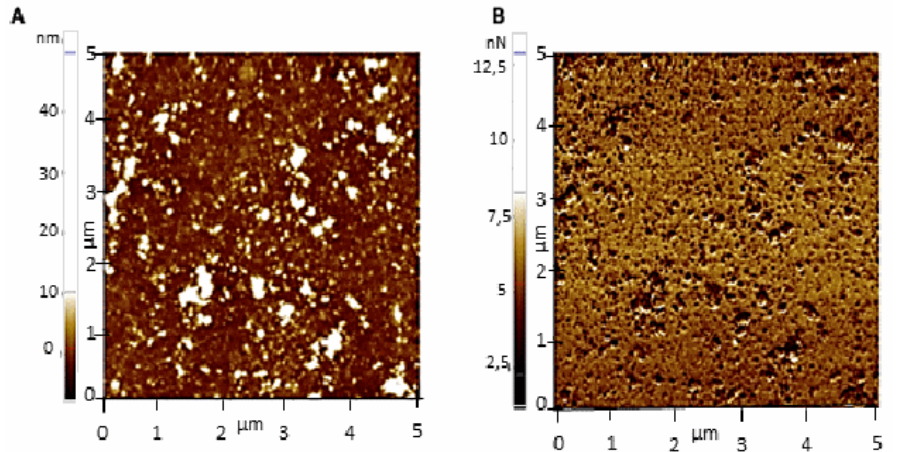
Figure 9. Topography and adhesion images of the molecular recognition of Ex-TcT of T. cruzi by anti-TS mAb 39 antibodies. ( A ) White dots represent the Ex-TcT distribution (20–30 nm for height and 50–330 nm in diameter). ( B ) Black dots represent the recognition of TS epitopes by the anti-TS mAb 39 antibodies during the scan process of the surface. Images were simultaneously acquired (5 × 5 µ